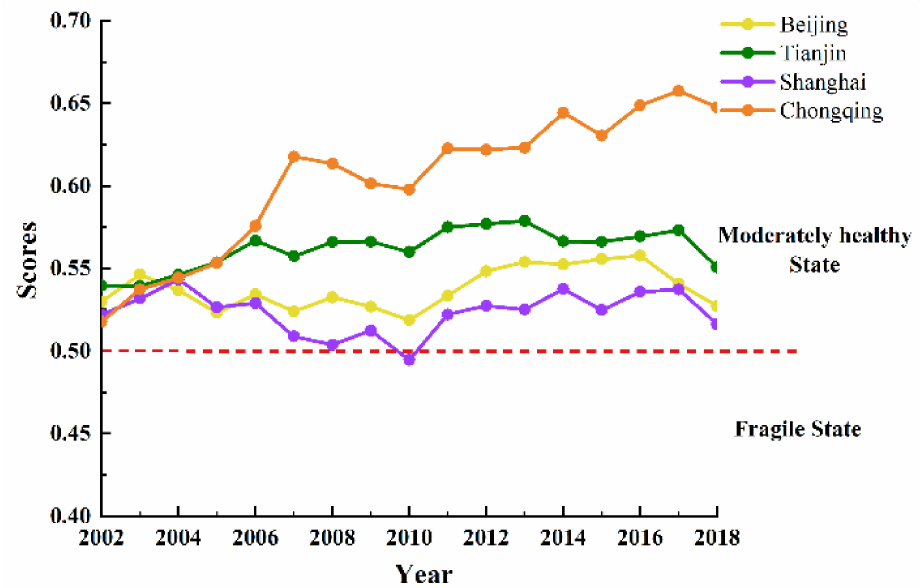
Figure 4. Trends in state resilience from 2002 to